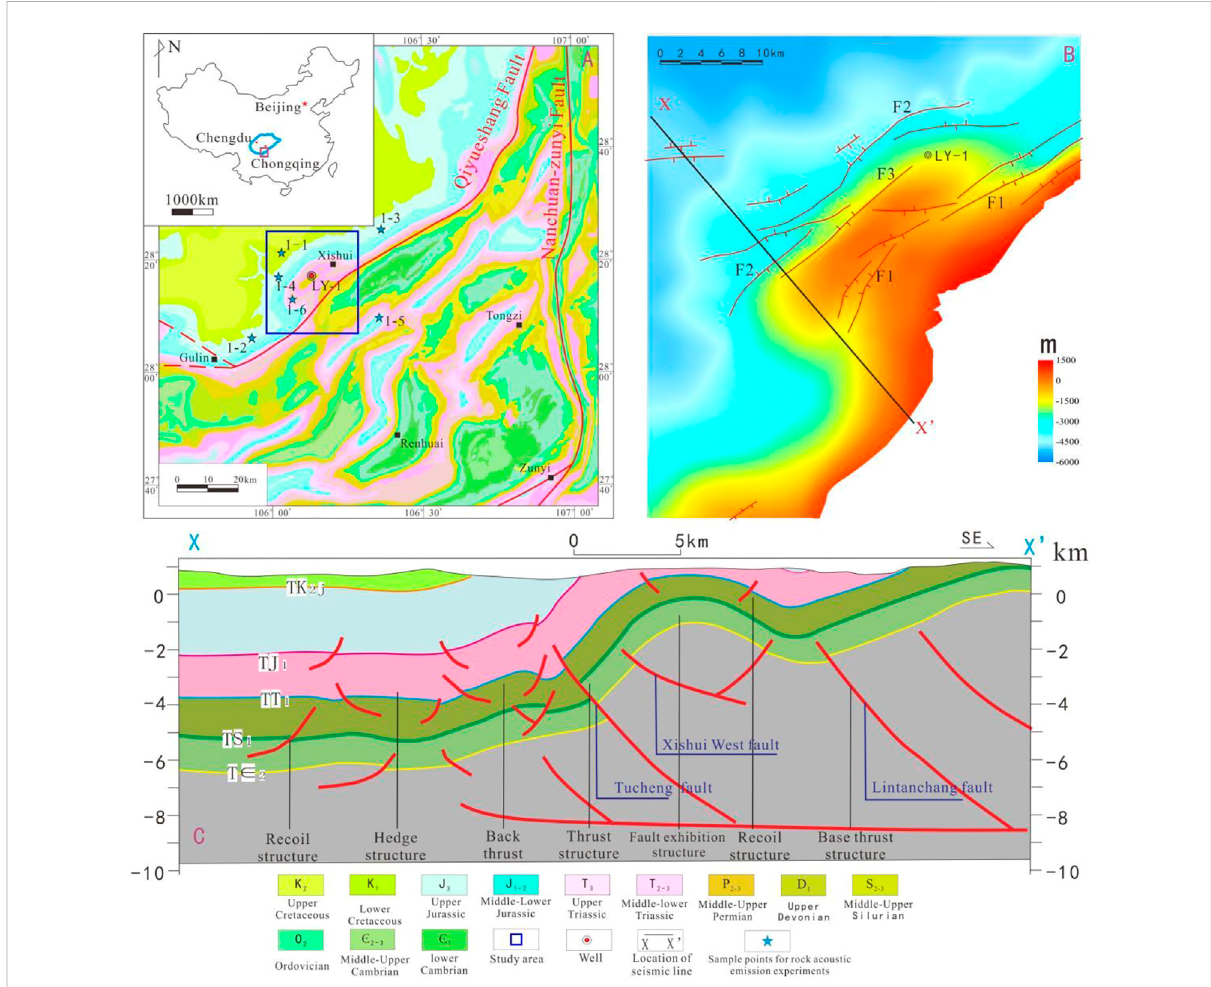
FIGURE 1 Regional structure of Lintanchang Area in eastern Sichuan Basin. Notes: (A) Geological map of Lintanchang area and adjacent areas in east Sichuan Basin (F1: Lintanchang Fault; F2: Tucheng Fault; F3: Xishuixi Fault); (B) Structure of the bottom surface of the Ordovician Wufeng Formation in the Lintanchang area; (C) Seismic interpretation pro fi le of line X-X ’